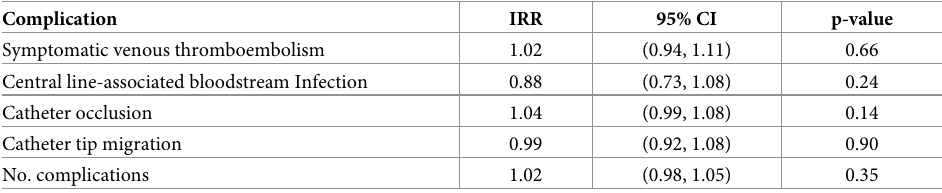
Table 4. Complications associated with number of PICC lumens based on 2017 manual chart review �